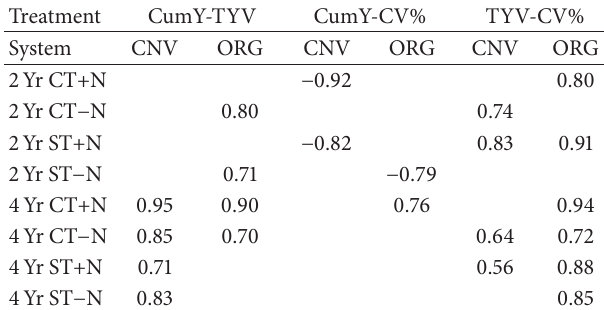
Table 3: Basic statistics for total yield, temporal variance, and coefficient of variation in each of the two cycles averaged over con- ventional and organic cropping systems in a long-term experiment. Variable